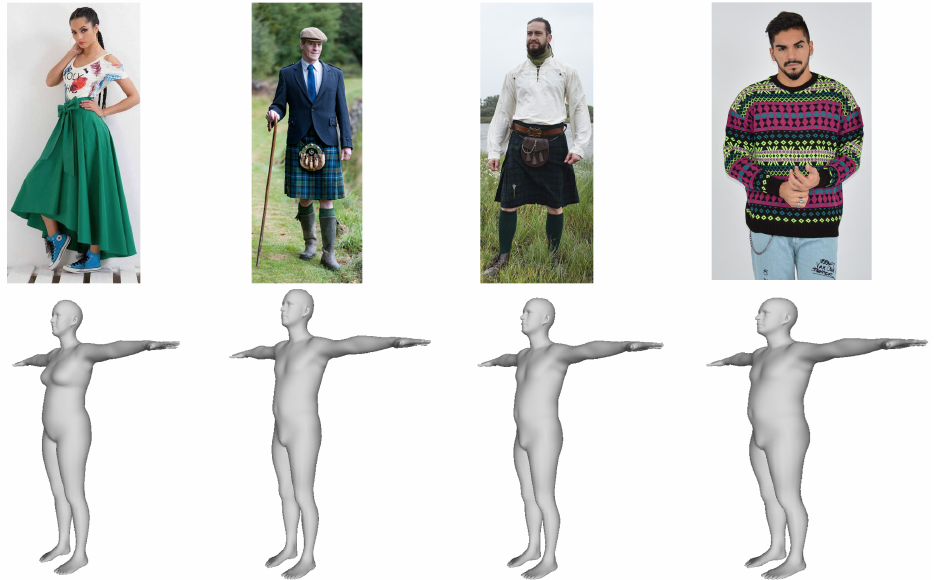
Figure 5. Qualitative reconstruction examples from “in the wild” images collected from